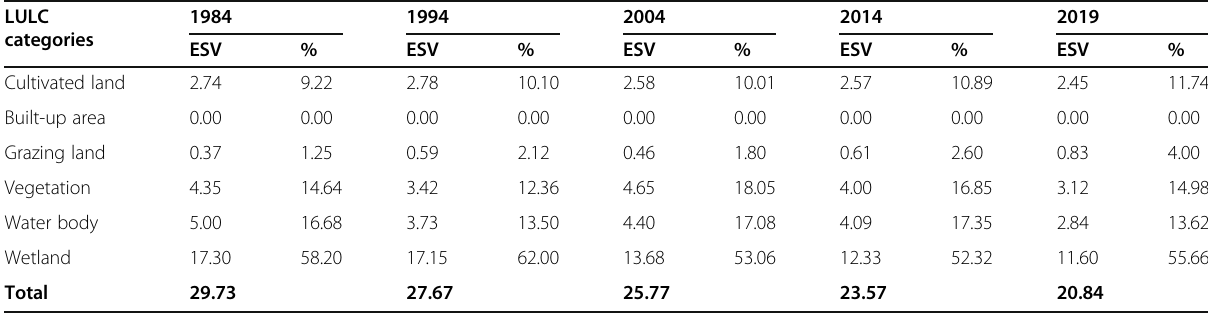
Table 7 The effects of land use/land cover (LULC) changes on the total ecosystem service values (ESV in USD ×10 6 ) of Bahir Dar